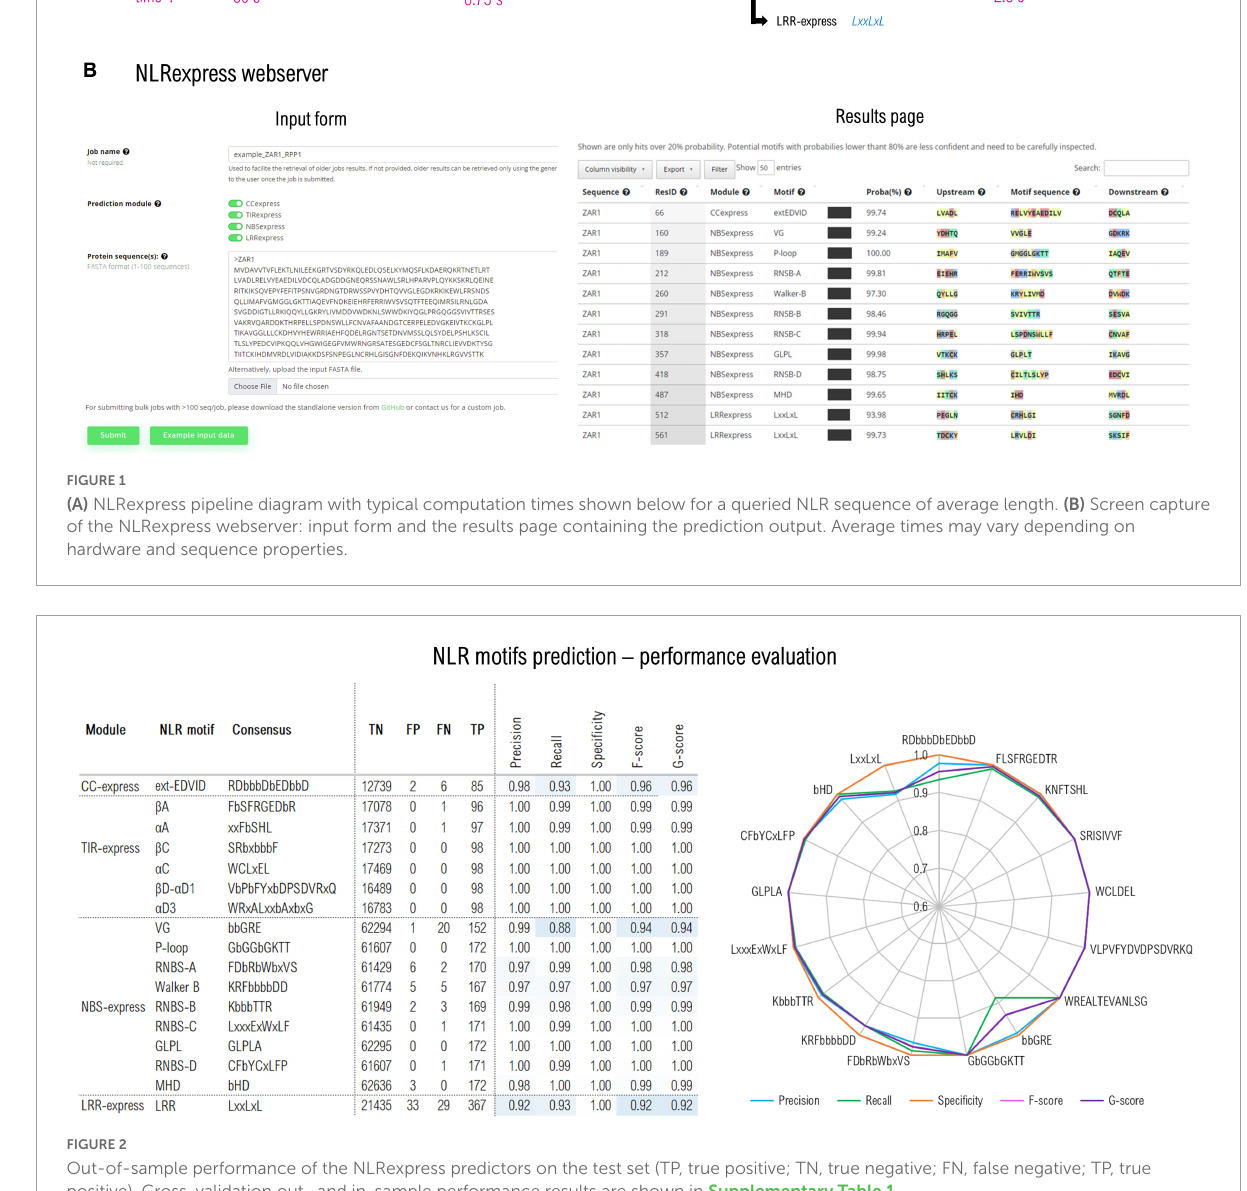
shown by the VG motif which is expected given its higher variability. Detailed stats on the cross-validation out-of-/in- sample performance can be examined from Supplementary Table 1